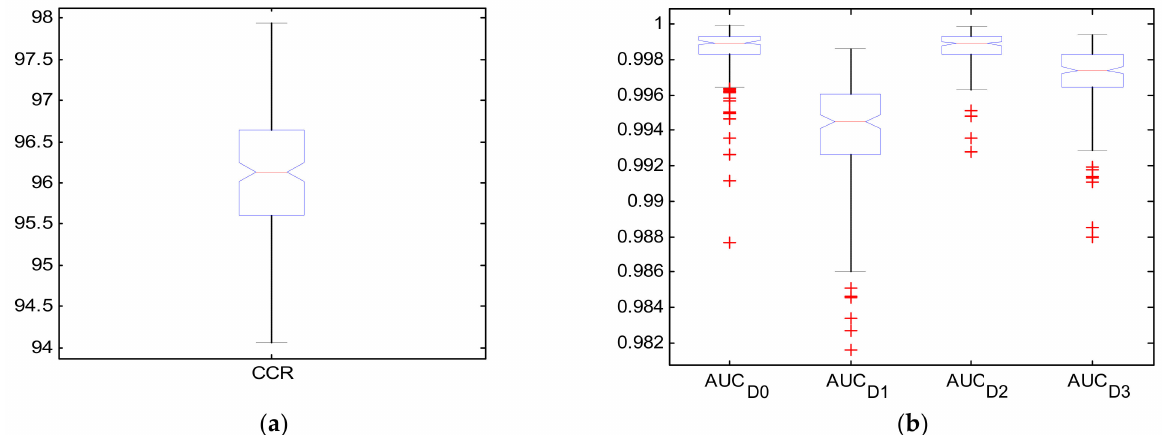
Figure 8. Box plots of the performance of the ANN-ICA classifier for the 200 repetitions: ( a ) correct classification rate (CCR); ( b ) area under the receiver operating characteristic (ROC) curve (AUC) for each class; AUC D0 , AUC D1 , AUC D2 and AUC D3 correspond to Days 0, 1, 2 and 3, respectively.